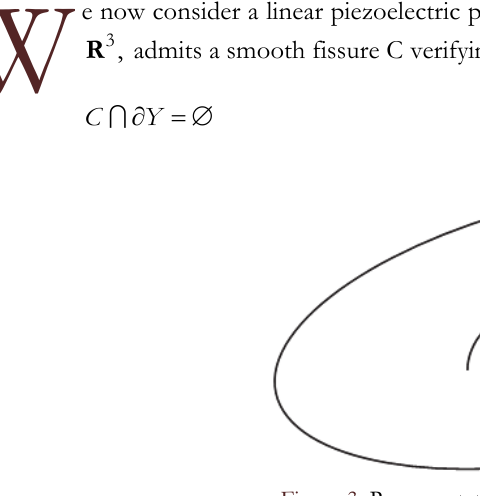
Figure 3: Representation of the period Y with a smooth fissure